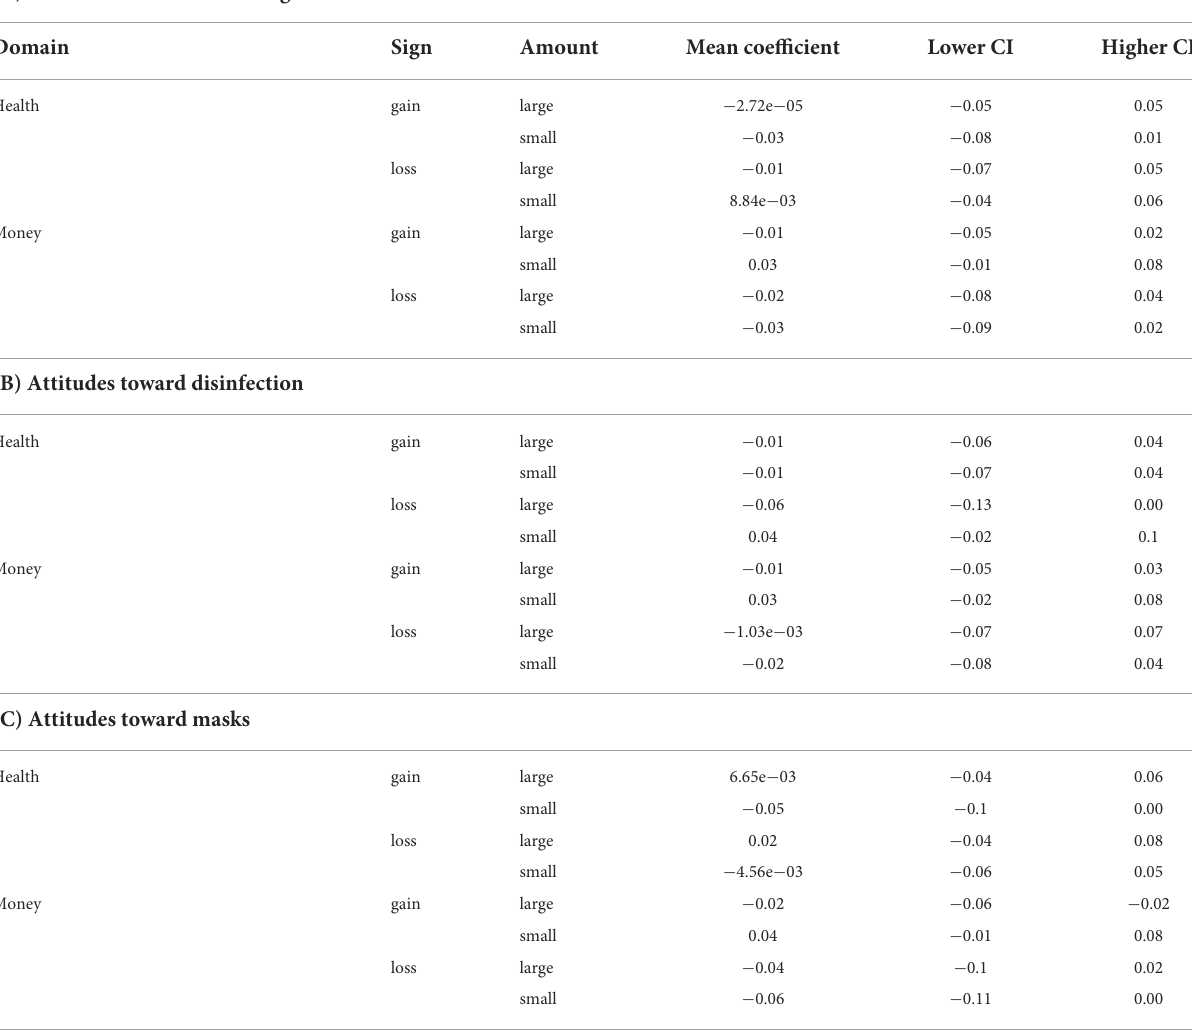
TABLE 2 Regression coefficients for DDM